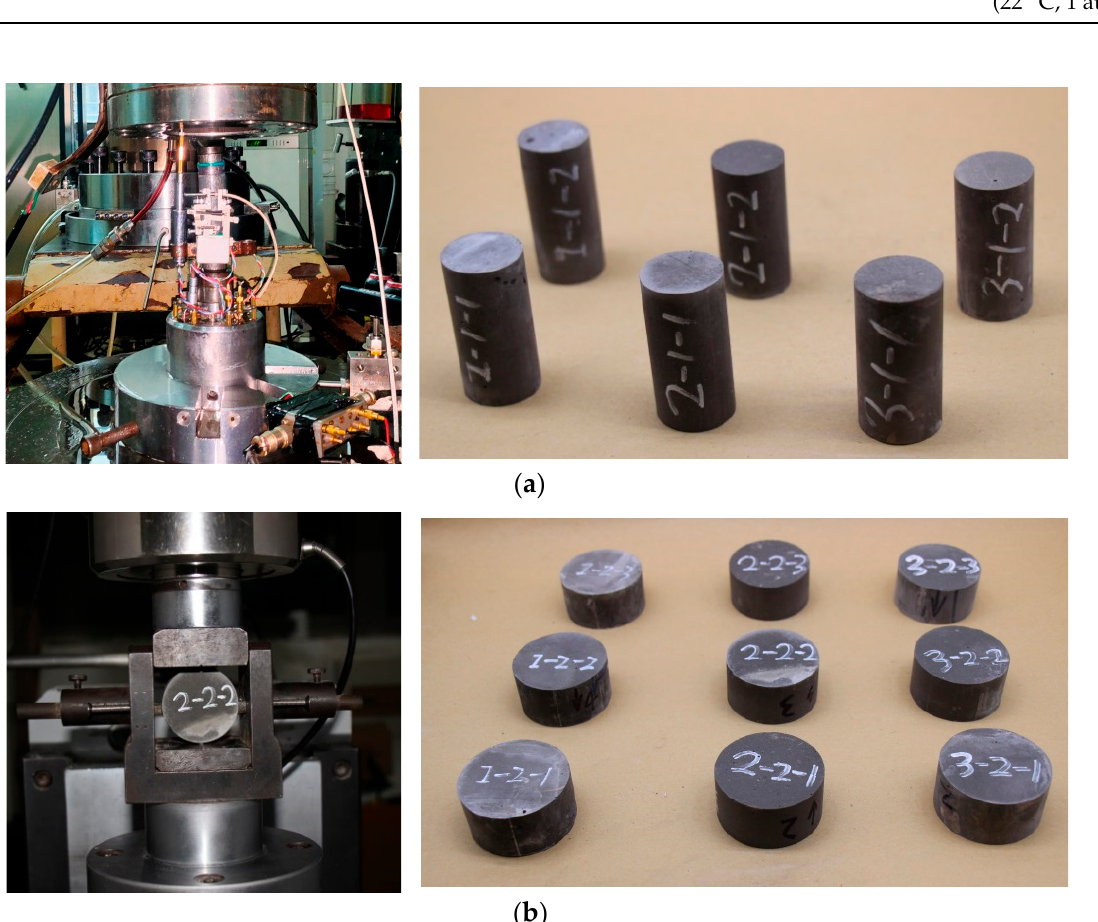
Figure 1. Testing and specimens. ( a ) Triaxial compression tests and specimens. ( b ) Brazilian splitting tensile strength tests and specimens.